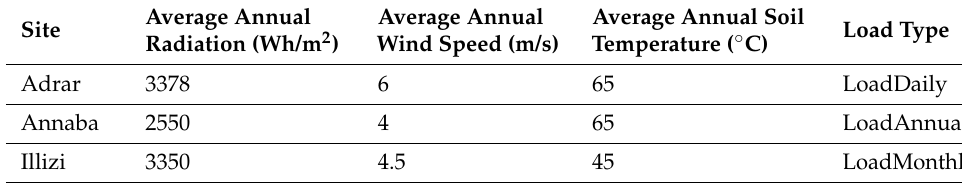
Table 6. Example of KB data.